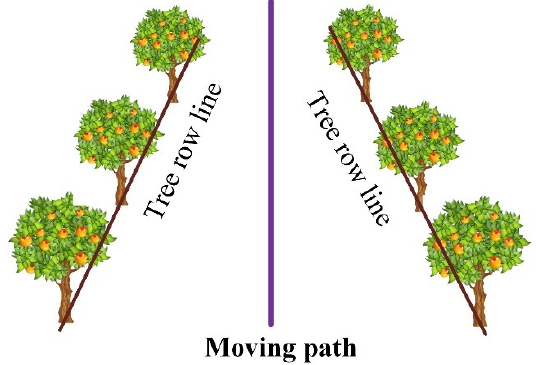
Figure 1. Schematic diagram of orchard navigation line extraction.